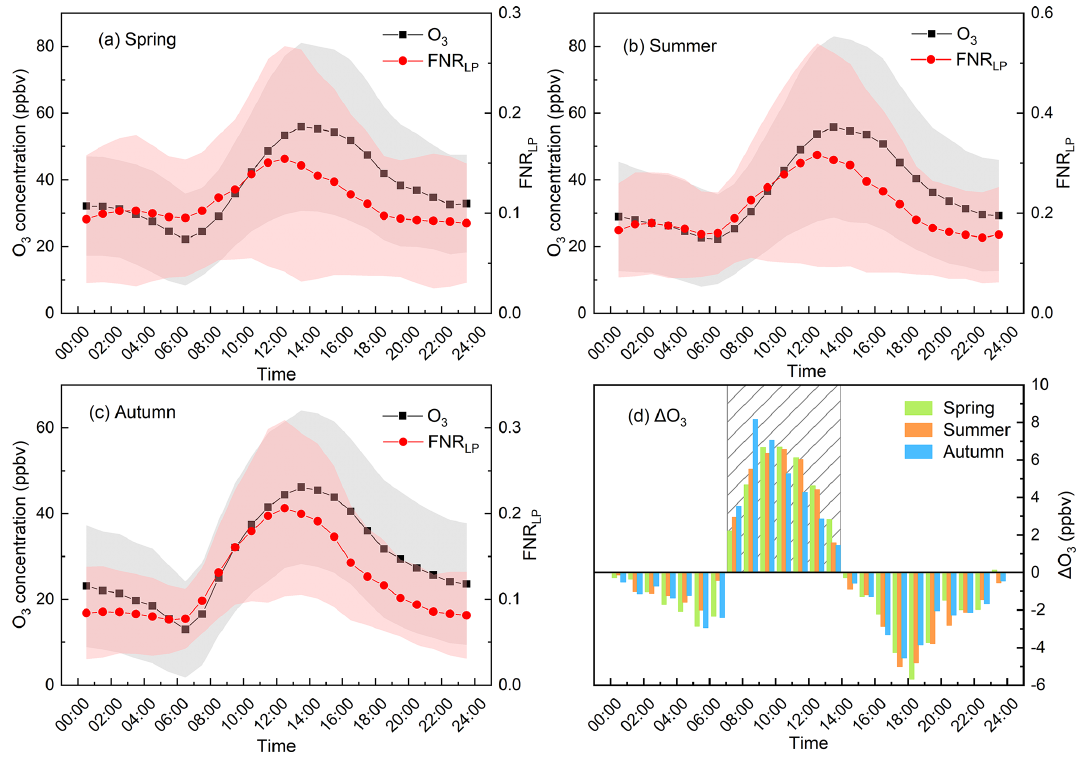
Figure 8. Diurnal variations of FNR LP , O 3 , and (cid:49) O 3 for spring, summer, and autumn during 2018–2019. (cid:49) O 3 represents increment of hourly O 3 concentration, as referred to in Eq. (3). The shaded area in (d) represents the period when (cid:49) O 3 greater than